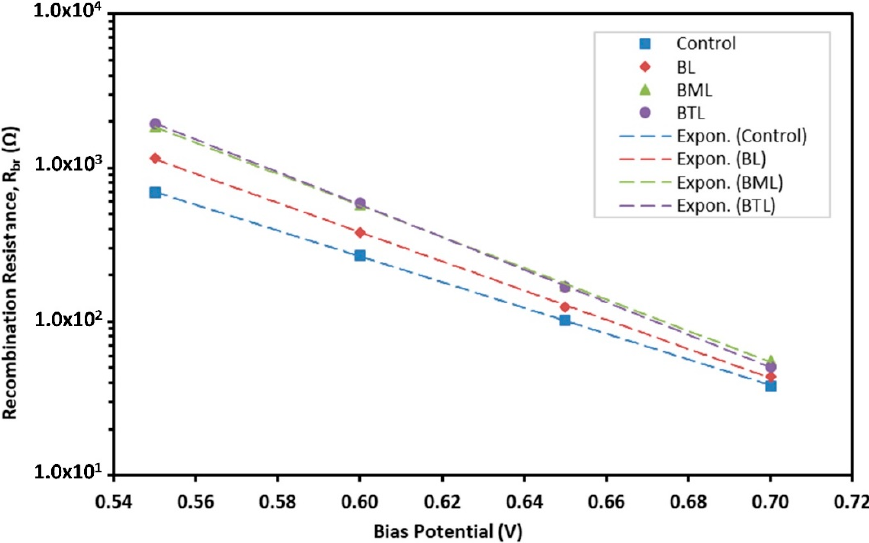
Figure 10. Electron recombination resistance, R br , of the fabricated DSSC integrated with and without the nanocrystalline TiO 2 layer.